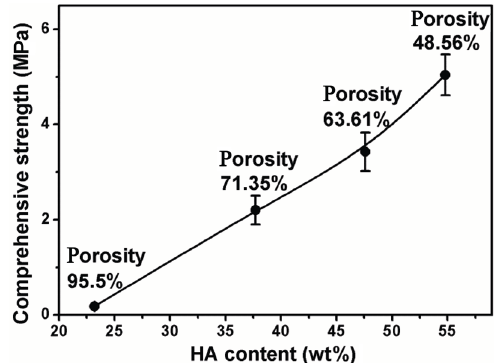
Fig. 6 Compressive strength of the gel − freeze cast HA ceramics which were sintered at 1100 ℃ for 6 h (mean±s.d., n =